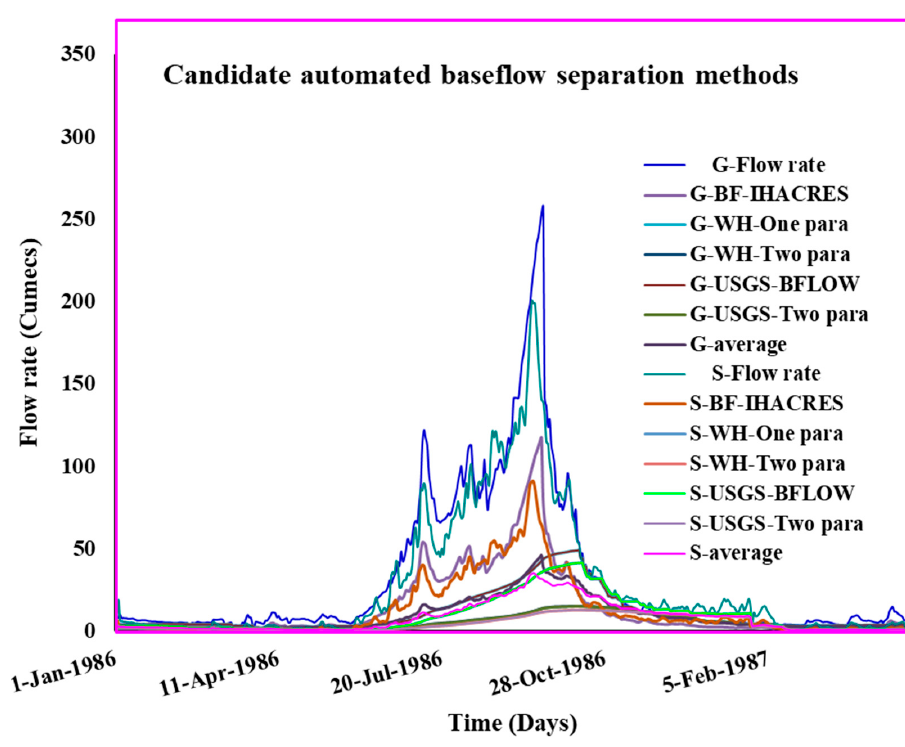
Figure 19. Baseflow separation using all candidate methods for both streams. (Results of all candidate methods are dis- played together. This figure shows a one-year baseflow separation).